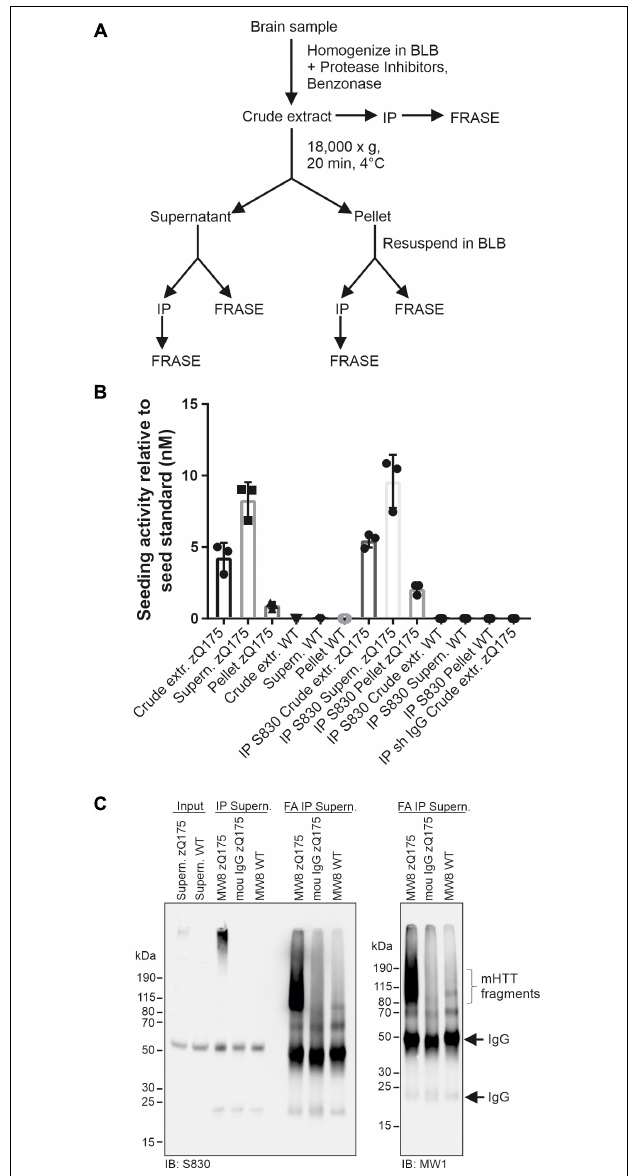
FIGURE 4 | Analysis of HTT seeding activity in soluble and insoluble zQ175 brain fractions. (A) Schematic representation of fractionation and analysis steps. (B) Analysis of mHTT seeding activity using different samples derived from fractionations of zQ175 and WT mouse brain homogenates following panel (A) . Immunoprecipitations (IP) were performed with the antibody S830 and a control IgG. Seeding activity was normalized to the seed standard. Data are mean ± SD of three technical replicates. (C) IP was performed with supernatant fraction (shown in panel (A) ) derived from WT and zQ175 mouse brain homogenates using antibody MW8 and mouse (mou) IgG. Immunoprecipitates were treated with formic acid (FA). Antibodies used for immunoblotting (IB) are indicated below the blots. Input, 200 µ g supernatant of zQ175 and WT brain